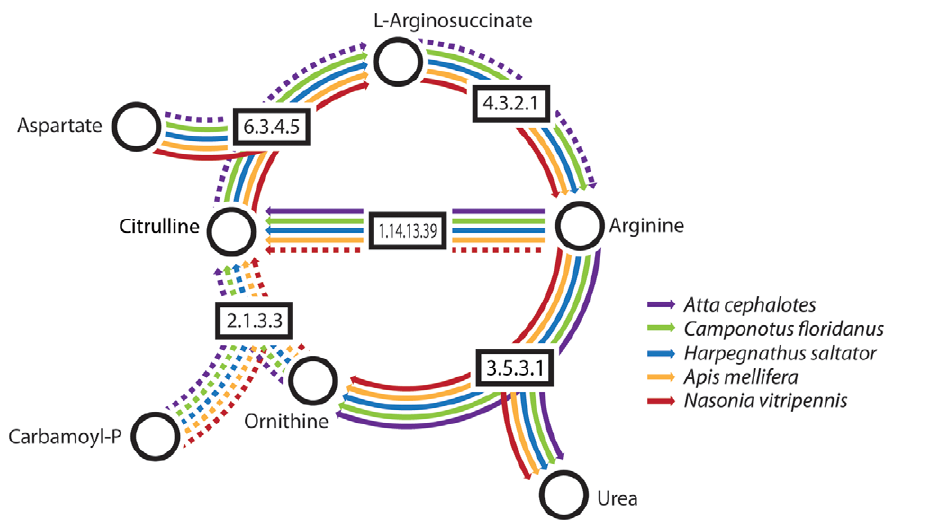
Figure 3. Predicted arginine biosynthesis pathway map in Attacephalotes , Camponotusfloridanus , Harpegnathussaltator , Apismellifera , and Nasoniavitripennis . This pathway in A. cephalotes was found to be missing the two enzymes agininosuccinate synthase (EC 6.3.4.5) and argininosuccinate lyase (EC 4.3.2.1), which catalyzes the conversion of aspartate and citrulline into arginine. Other enzymes in this pathway include ornithine cabamoyltransferase (EC 2.1.3.3), arginase (EC 3.5.3.1) and nitric oxide synthase (EC 1.14.13.39). Dotted arrows indicate genes encoding proteins which were not found.